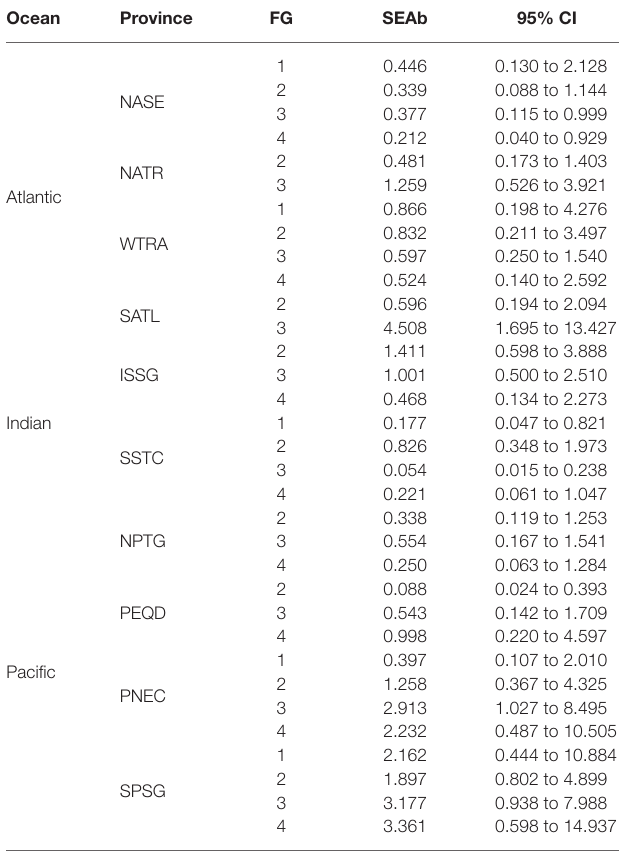
Estimates are presented as the mode of the Bayesian standard ellipse area (SEAb). Lower and upper 95% CI indicate the uncertainty in the SEAb estimates.